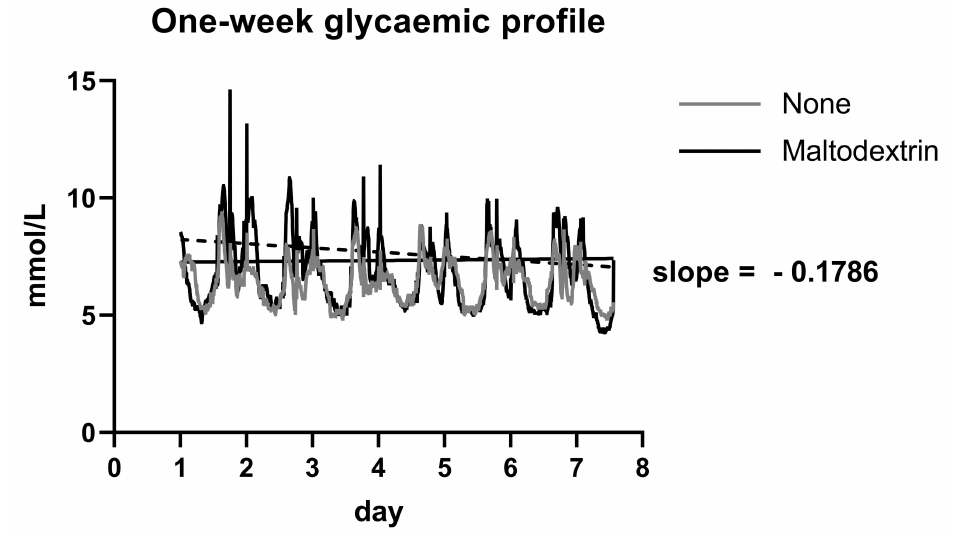
Figure 4. One-week glycemic profile: the patients receiving maltodextrin had higher glycaemia during the postprandial period. This phenomenon was significantly blunted in latter half of the follow-up and the glycaemia in this cohort had a decreasing tendency (slope of − 0.1786; p <